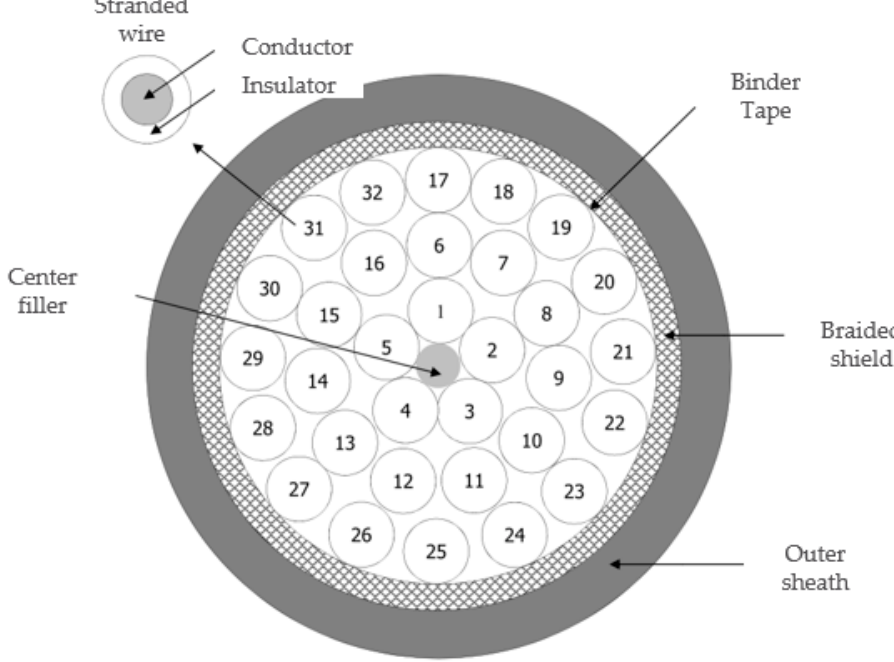
Figure 1. Cross-sectional view of motor power cable (COVV-SB 32C × 1.5SQ).